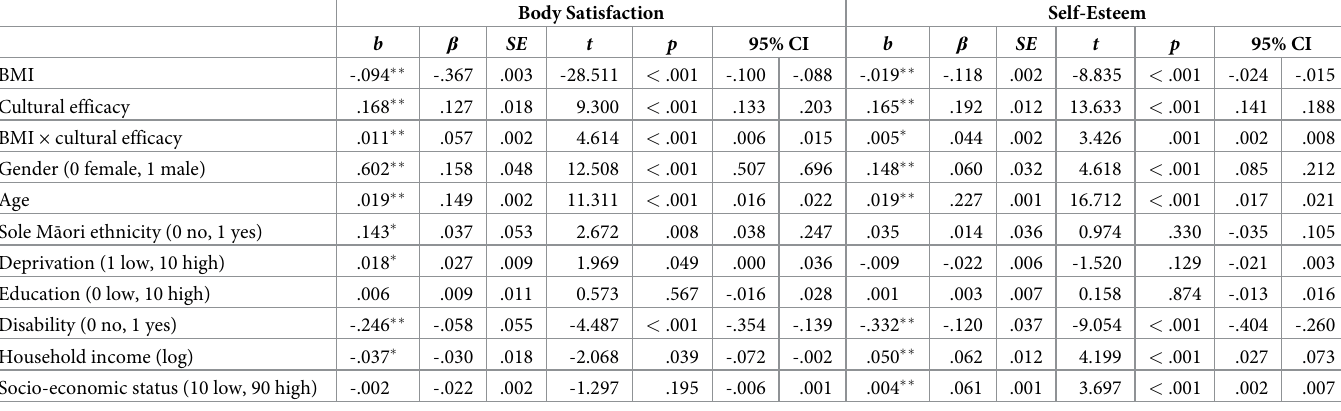
Table 2. Multiple regression predicting body satisfaction and self-esteem by BMI, cultural efficacy, and